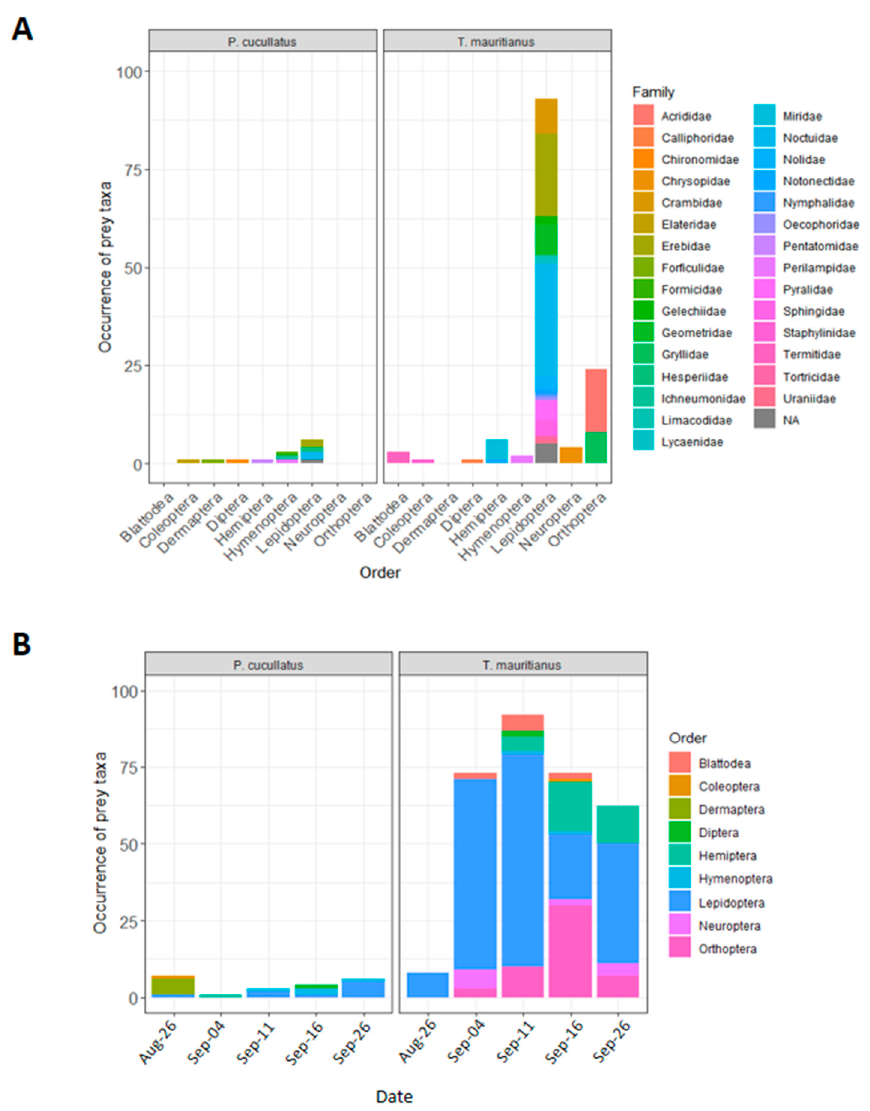
Figure 3. ( A ) Diet composition of insectivorous birds ( Ploceus cucullatus) and bats ( Taphozous mauritianus ) inferred from DNA sequences detected in fecal samples. ( B ) Diet composition as a function of sampling date throughout the reproductive stage of millet. Occurrence of prey taxa is the cumulated number of OTUS identified from fecal samples.